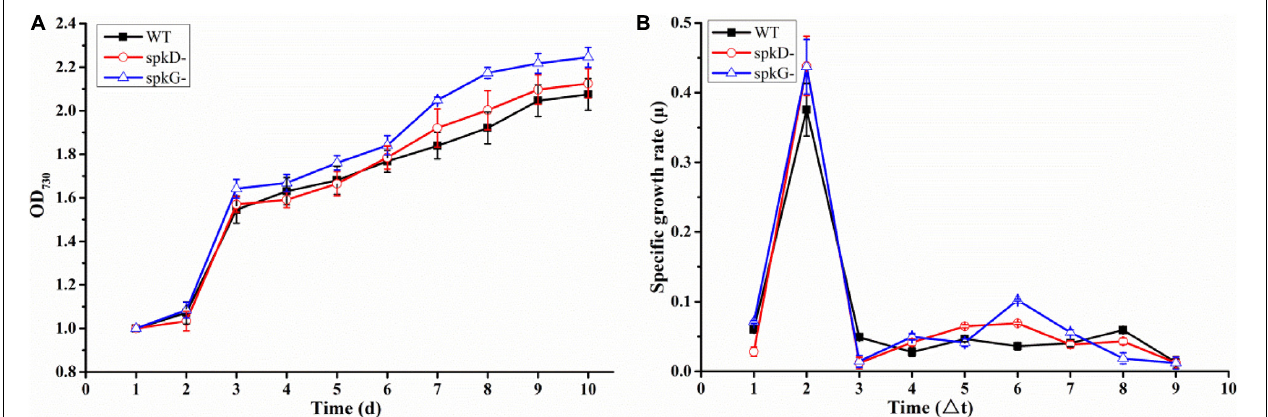
FIGURE 2 | Growth curves and specific growth rates of mutant and wild type cultures under normal light conditions (A) Growth curves of wild type Synechocystis sp. PCC6803 and two knockout mutants; (B) Specific growth rates of wild type Synechocystis sp. PCC6803 and two knockout mutants. WT represents wild type; spkD represents spkD knockout mutant; and spkG represents spkG knockout mutant. The experiment was carried out under a normal light intensity of 40 µ mol · m − 2 · s − 1 . (cid:77) t is the length of the time interval in days. Values are means ± SD (bars) of three independent experiments conducted on different days. The absence of a bar indicates that the SD falls within the